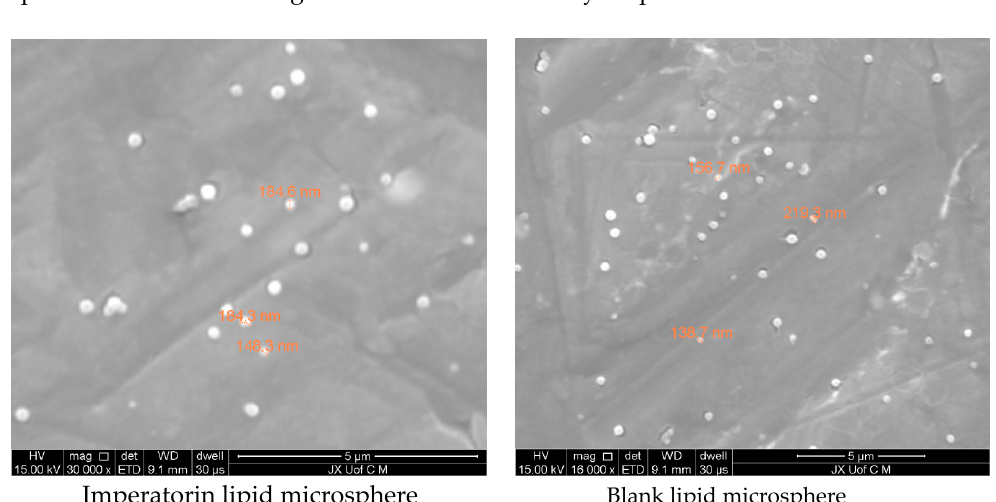
Figure 2. Scanning electron microscopy of imperatorin lipid microspheres.